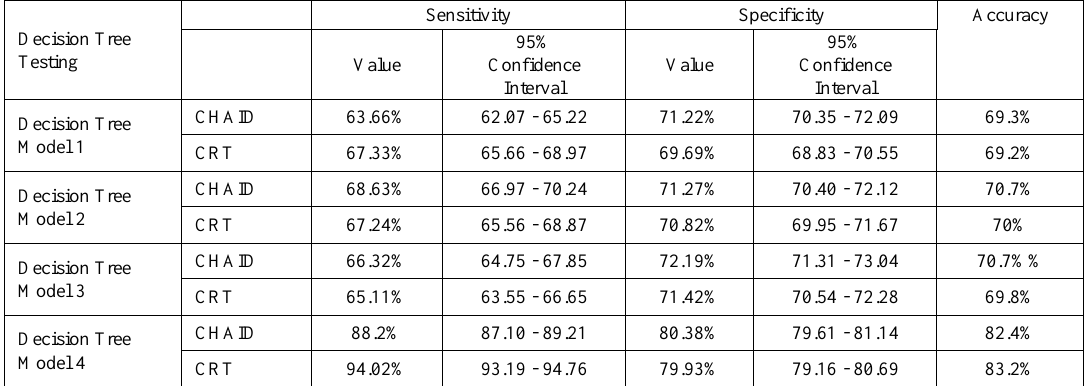
Table 7. Decision trees testing results: sensitivity, specificity and accuracy